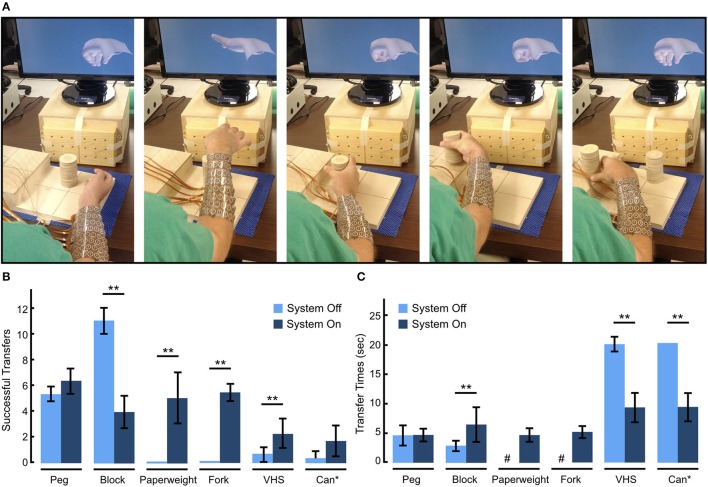
Functional performance evaluation using the Grasp and Release Test (GRT). (A) Sequential snapshots of the participant manipulating the Can object as part of the GRT. The participant starts from a rest state, opens his hand and place it around the Can, grasps the Can, transfers it to the raised platform, and then releases the Can. A new object is then placed in front of the participant to attempt the next transfer. (B) GRT scores showing the mean number of successful transfers with and without the BCI-FES system. With the use of the system, the participant not only improved his GRT scores over his baseline, demonstrating an increase in number of transfers for all objects except the Block, but was also able to grip and transfer two objects (Paperweight, Fork) that he could not manipulate at baseline. (C) Mean transfer times for each object with and without the BCI-FES system. With the use of the system the participant's transfer speed increased for all objects except for the Peg and Block which he was able to transfer faster on his own using adaptive grips. #The participant was never able to transfer these objects without the system. *The Can transfer required two hand movements—Hand Open and Can grasp. **p < 0.05 (paired t-test).